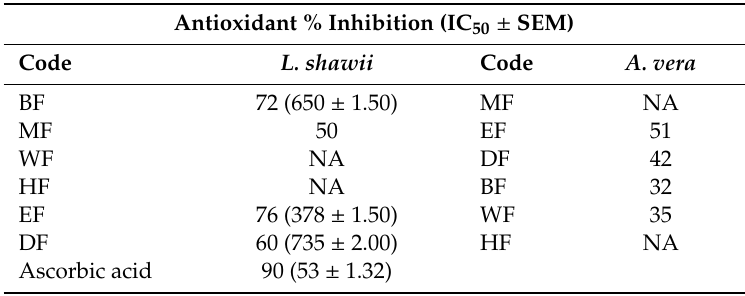
Table 2. Antioxidant activity of di ff erent fractions of L. shawii and A. vera resin.